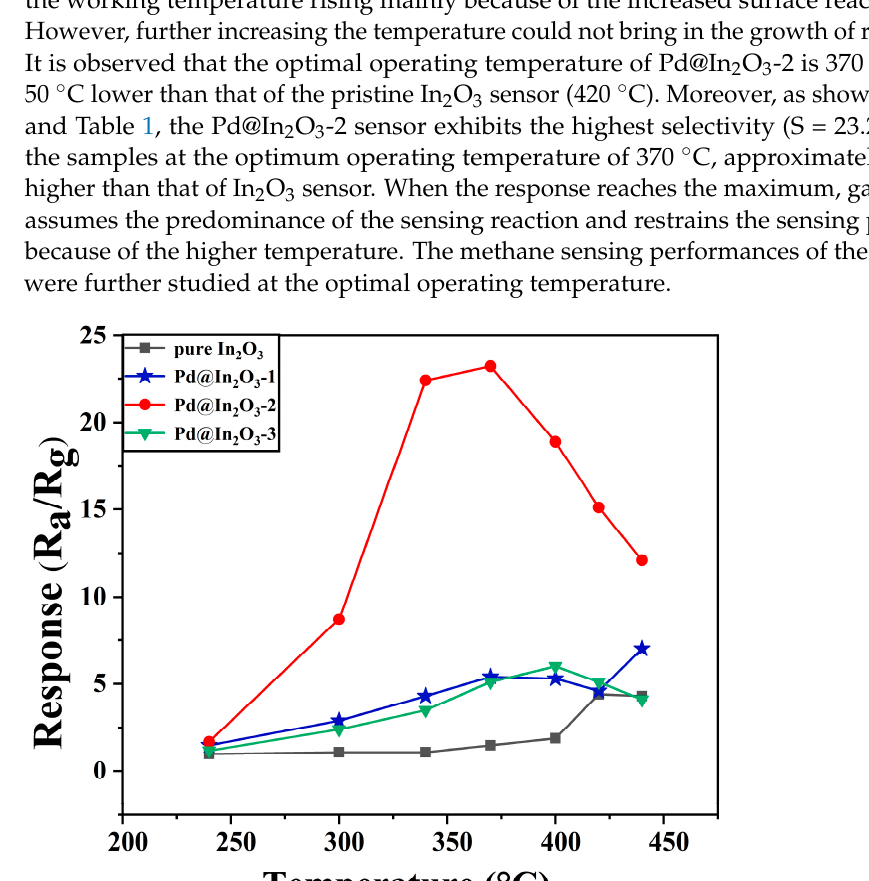
Table 1. Response of pristine In 2 O 3 and Pd@In 2 O 3 -1, Pd@In 2 O 3 -2, and Pd@In 2 O 3 -3 samples at differ- ent temperatures.